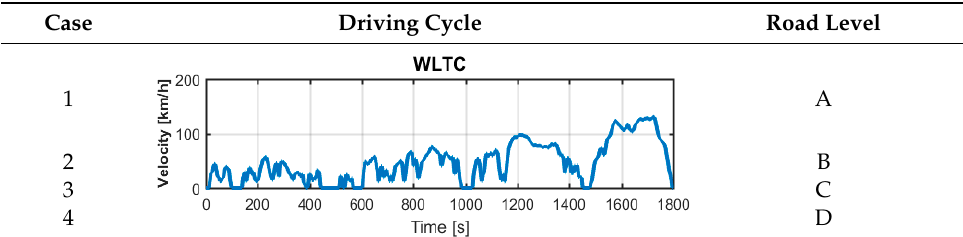
Figure 12. Comparative results for different cases. ( a ) Suspension GHG emission reduction; ( b ) WTW GHG emissions of a light-duty BEV. Table 5. Di ff erent cases of driving cycles and road levels. Table 5. Different cases of driving cycles and road